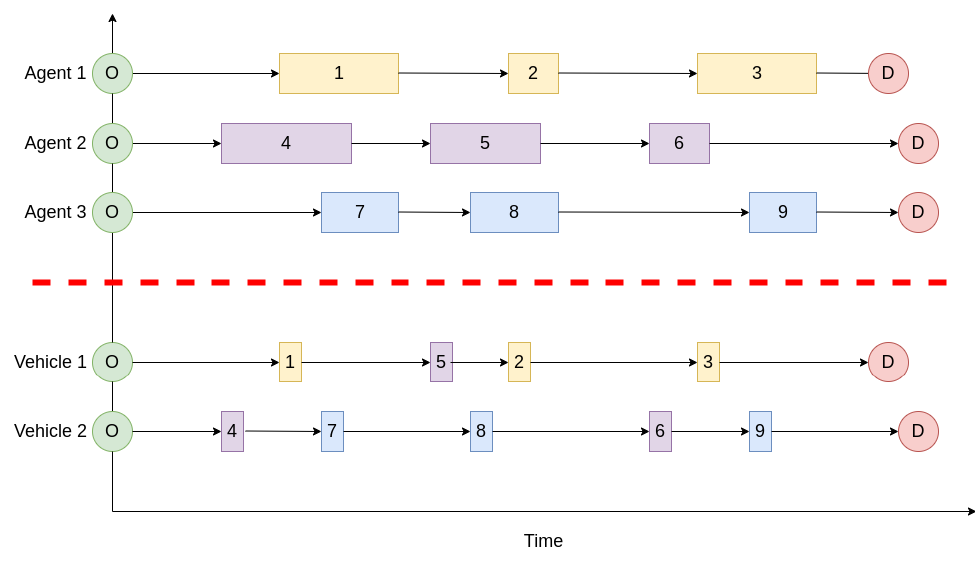
Figure 1. A simple example of a dynamic optimization problem with synchronization